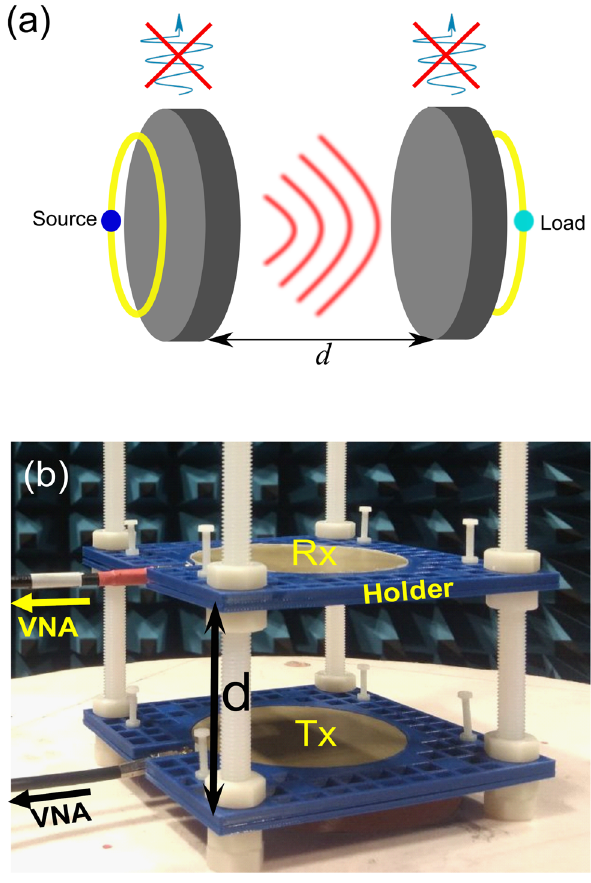
Figure 5: NR WPT system design.